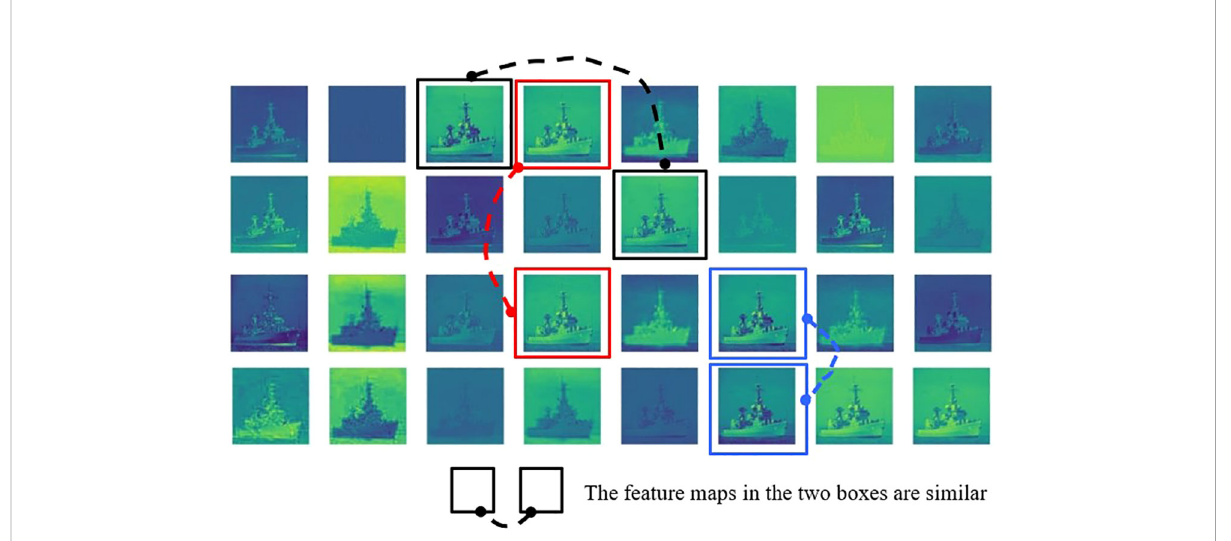
FIGURE 4 Redundant feature maps generated by original